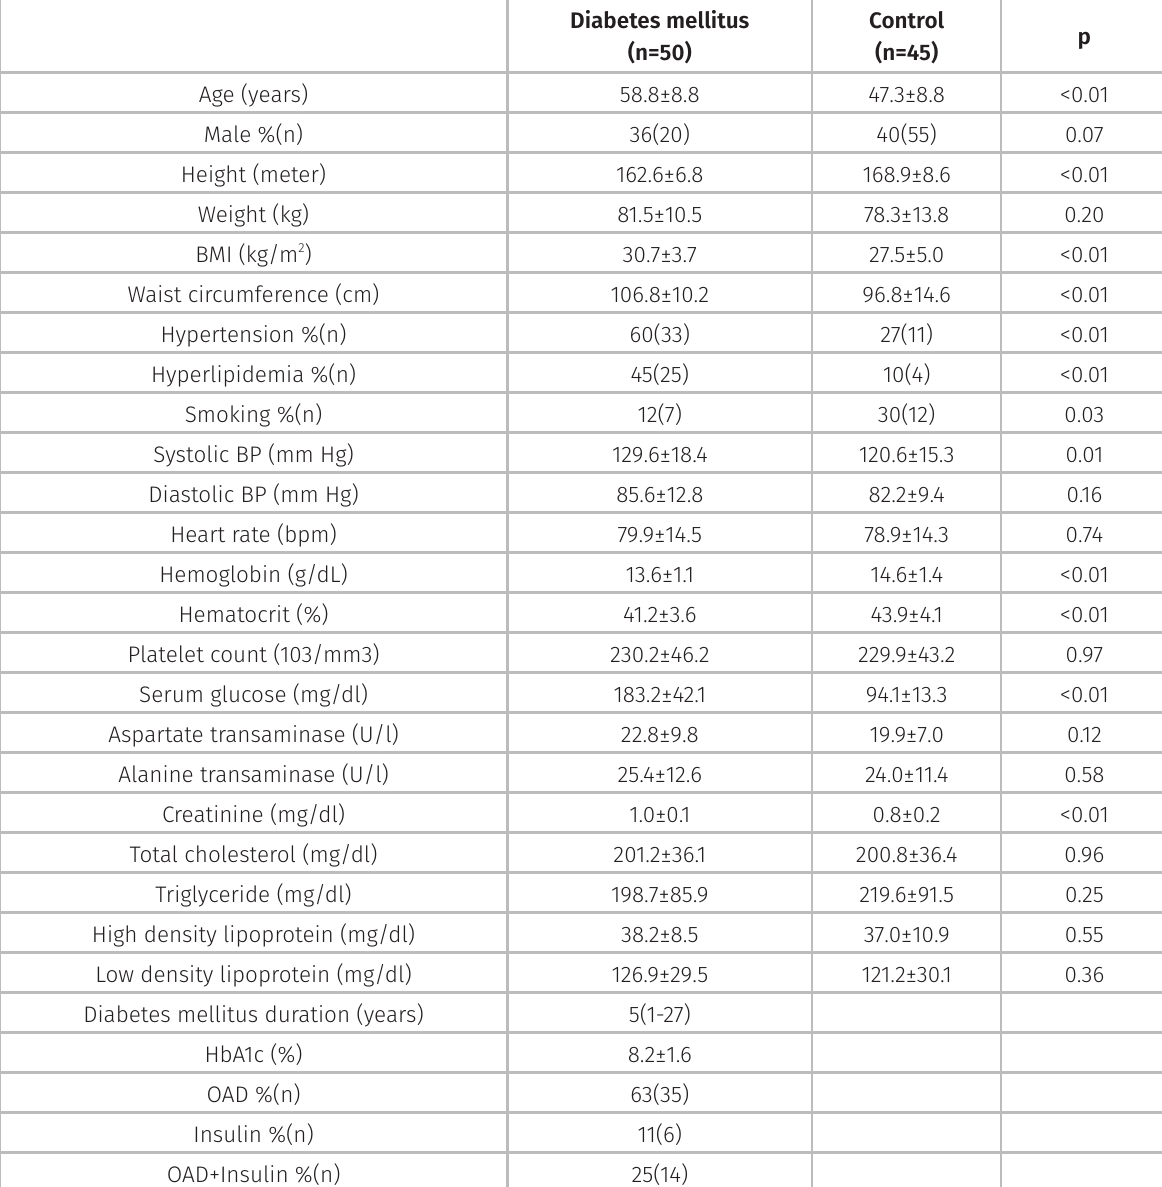
Table I. Baseline demographic features and laboratory parameters of the study